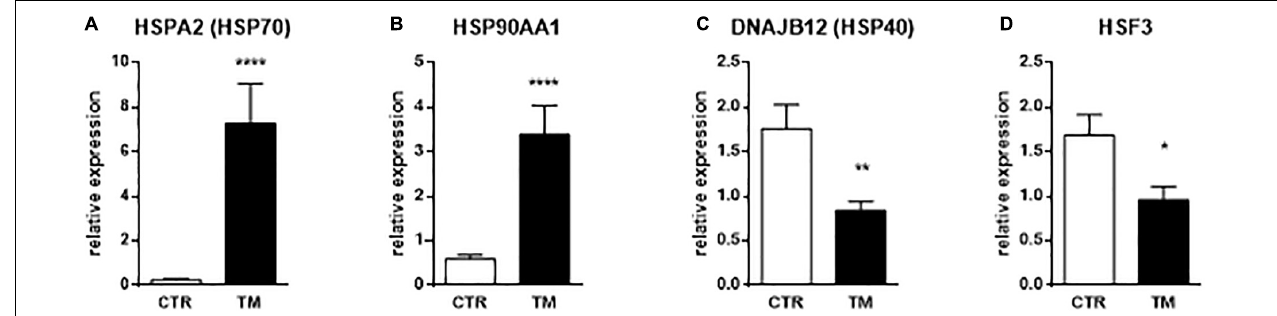
FIGURE 2 | Hepatic relative expression of genes directly influenced by heat treatment at E27. Column representation of the relative expression of HSPA2 (A) , HSP90AA1 (B) , DNAJB12 (C) , and HSF3 (D) at the end of the thermal manipulation in the liver of control (CTR) or thermal manipulated (TM) duck embryos. Data are presented as mean +/– SEM ( n = 18–19). * P < 0.05, ** P < 0.01, **** P < 0.0001. TABLE 1 | Hepatic relative expression of genes involved in the lipid and carbohydrate pathways depending on incubation conditions before and after overfeeding. Control TM Effects Metabolic pathway